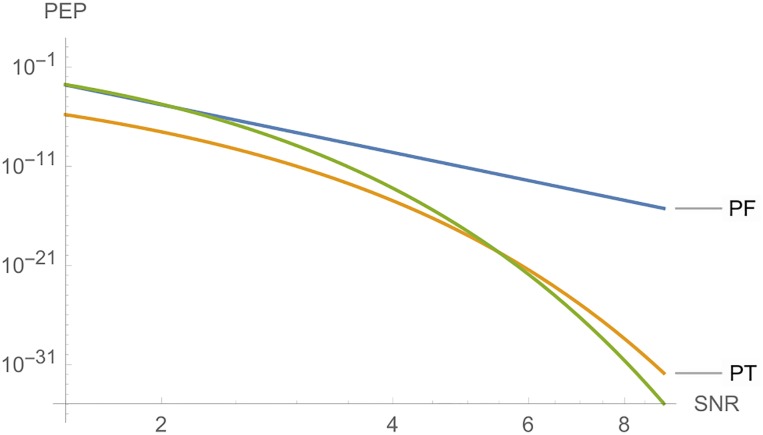
Graphs of PE, PF and PT for Example 4, where nT = nR = l = 4, and SNR is a function of Es.